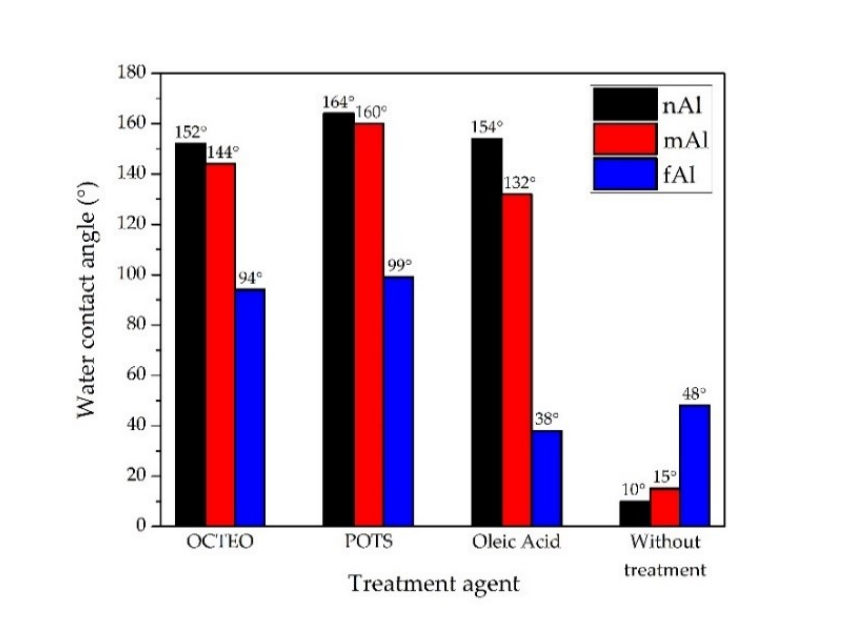
Figure 3. Surface water contact angles of treated textures.